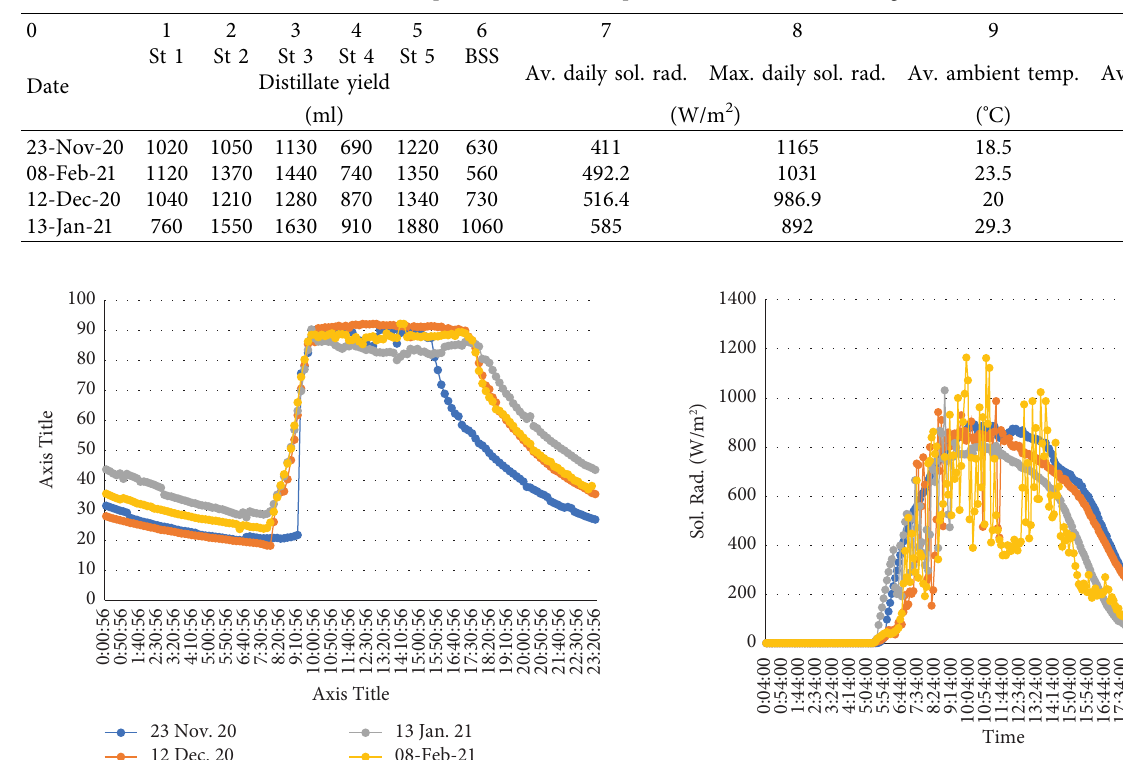
Table 4: Various parameters of the vapour-based MSS-SS under high conditions.